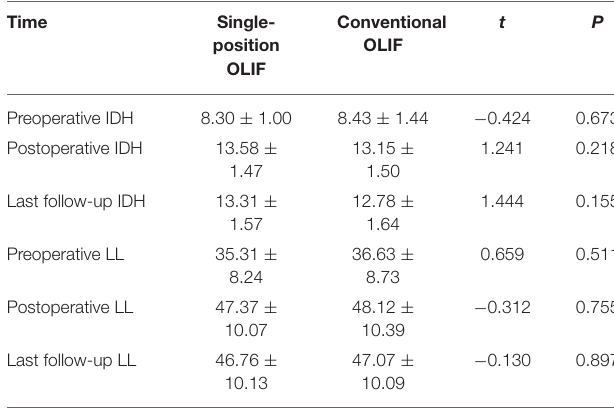
TABLE 1 | General patient data. Groups Single-